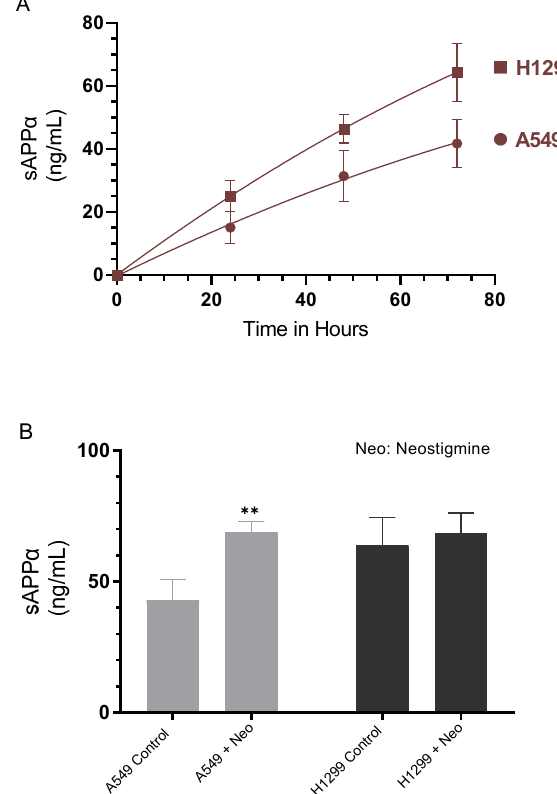
Figure 2. Cell treatment with neostigmine increased sAPP α in A549 cell media to levels comparable to those measured in H1299 cell media. Cells (0.2 × 10 5 ) were grown in 10% FBS-supplemented media for 24 h. The following day, the cell monolayers were incubated in serum-free media for the indicated times ( A ) and the levels of sAPP α were measured as described in the Methods section. The levels of sAPP α ( B ) were measured in the media of cells grown as in ( A ) and incubated without or with 50 µ M neostigmine (Neo) for 72 h. The same amount of protein (3 µ L of 600 µ g/mL total protein) of the media was used for the quantitation. Data from five independent assays, each carried out in triplicate, were averaged using the GraphPad 9.4.1 software. The graphs summarize the results expressed as means ± SD (n = 5). Asterisks indicate a statistically significant difference from the corresponding controls, ** p < 0.01 of each cell line. Absence of asterisks indicates no significance, Mann–Whitney